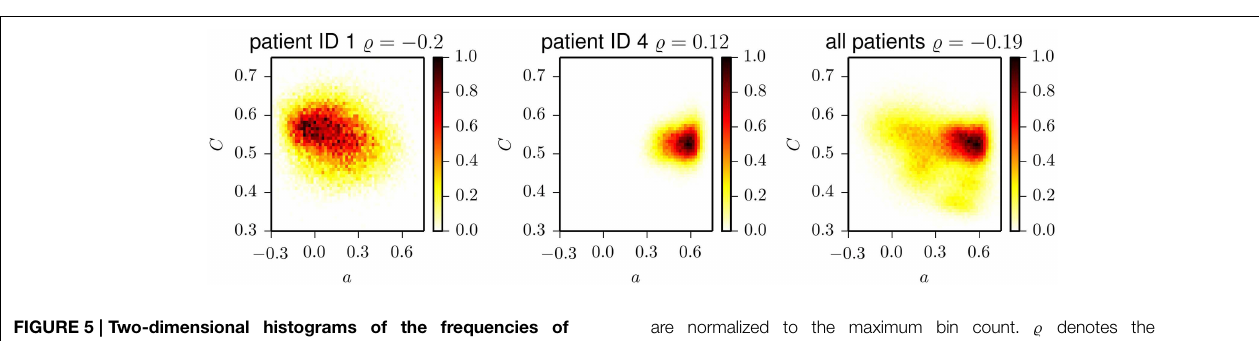
FIGURE 5 | Two-dimensional histograms of the frequencies of occurrence of pairs ( a , C ) for patient 1 (left), patient 4 (middle), and aggregated for all patients (right). Histograms